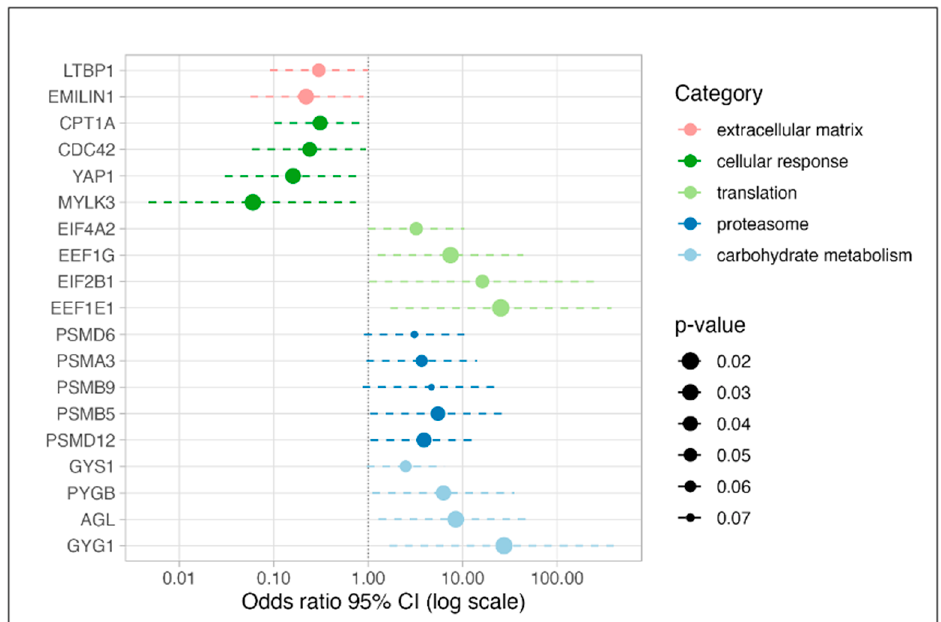
Figure 3. Forest plot of Odds ratios for proteins of specific categories being characteristic of aortic regurgitation (AR; Odds ratio > 1) or aortic stenosis phenotype (AS; Odds ratio < 1). p -values and Odds ratio calculated for each protein by the glm function of the stats package in R using LFQ protein intensities. GO term categorization derived from g:Profiler.